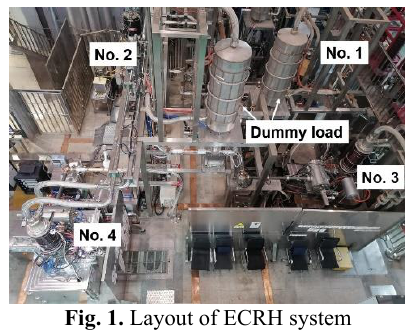
Fig. 1. Layout of ECRH